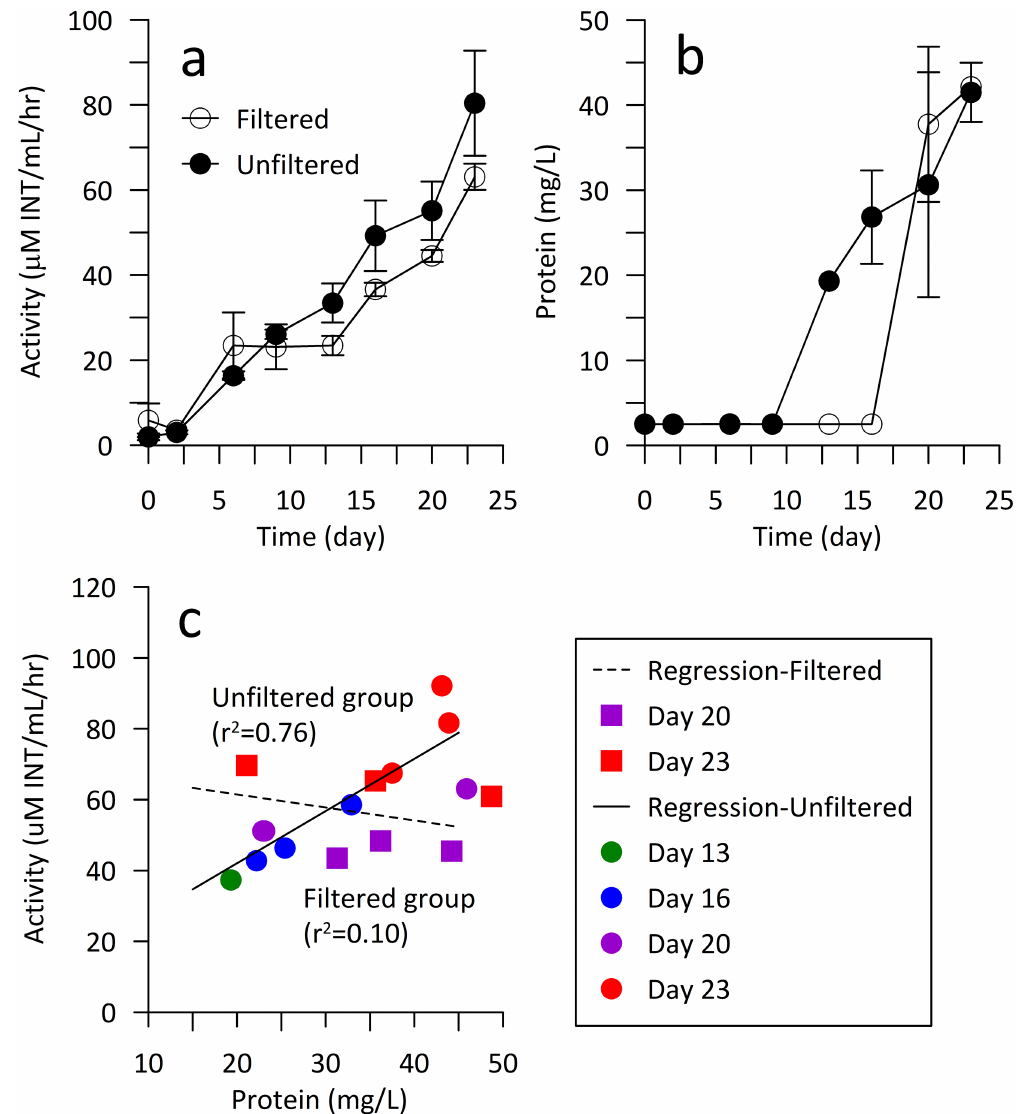
Fig 2. Microbial activity within the reacted groundwater. (a) Dehydrogenase activity and (b) total protein ( ± standard deviation) of planktonic communities (i.e. reacted groundwater) in bioreactors from filtered (open square) and unfiltered (closed square) groups. (c) Variation in hydrogenase activity versus total